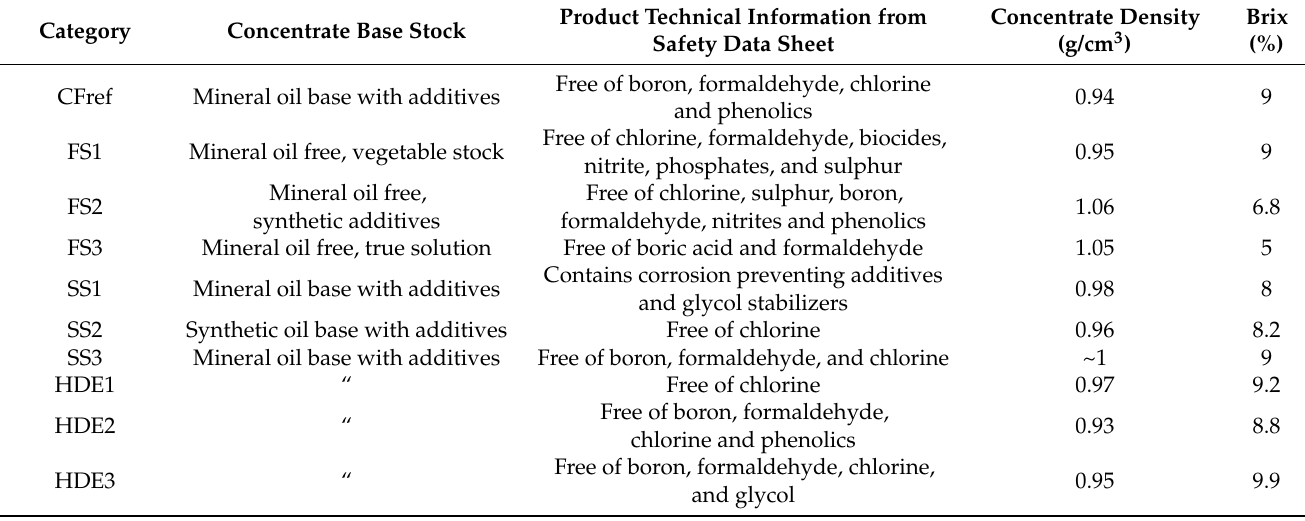
Table 4. Category and description of